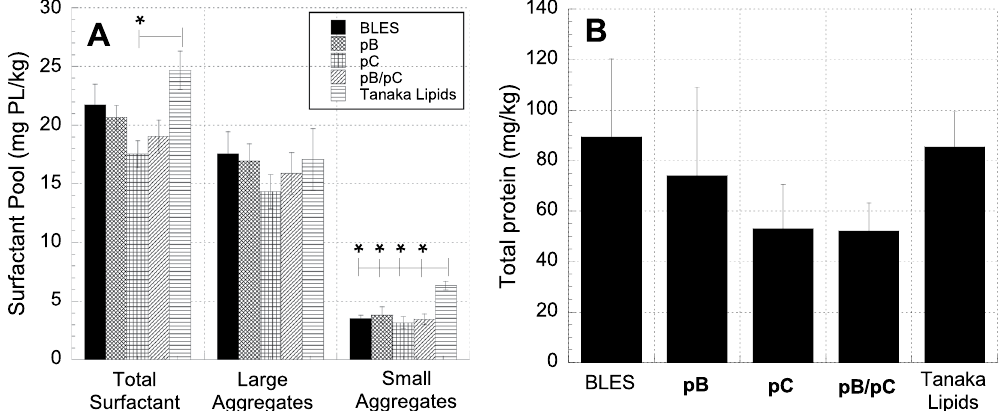
Figure 4. Surfactant pool characterization in broncheoalveolar lavage (BAL). ( A ) Average amounts of total surfactant, large aggregates, and small aggregates in BAL. ( B ) Average total protein content in the BAL of each treatment group. Error bars indicate the standard error of the mean. Statistical significance indicators: * indicates p < 0.05 for the difference between the designated group and TL alone